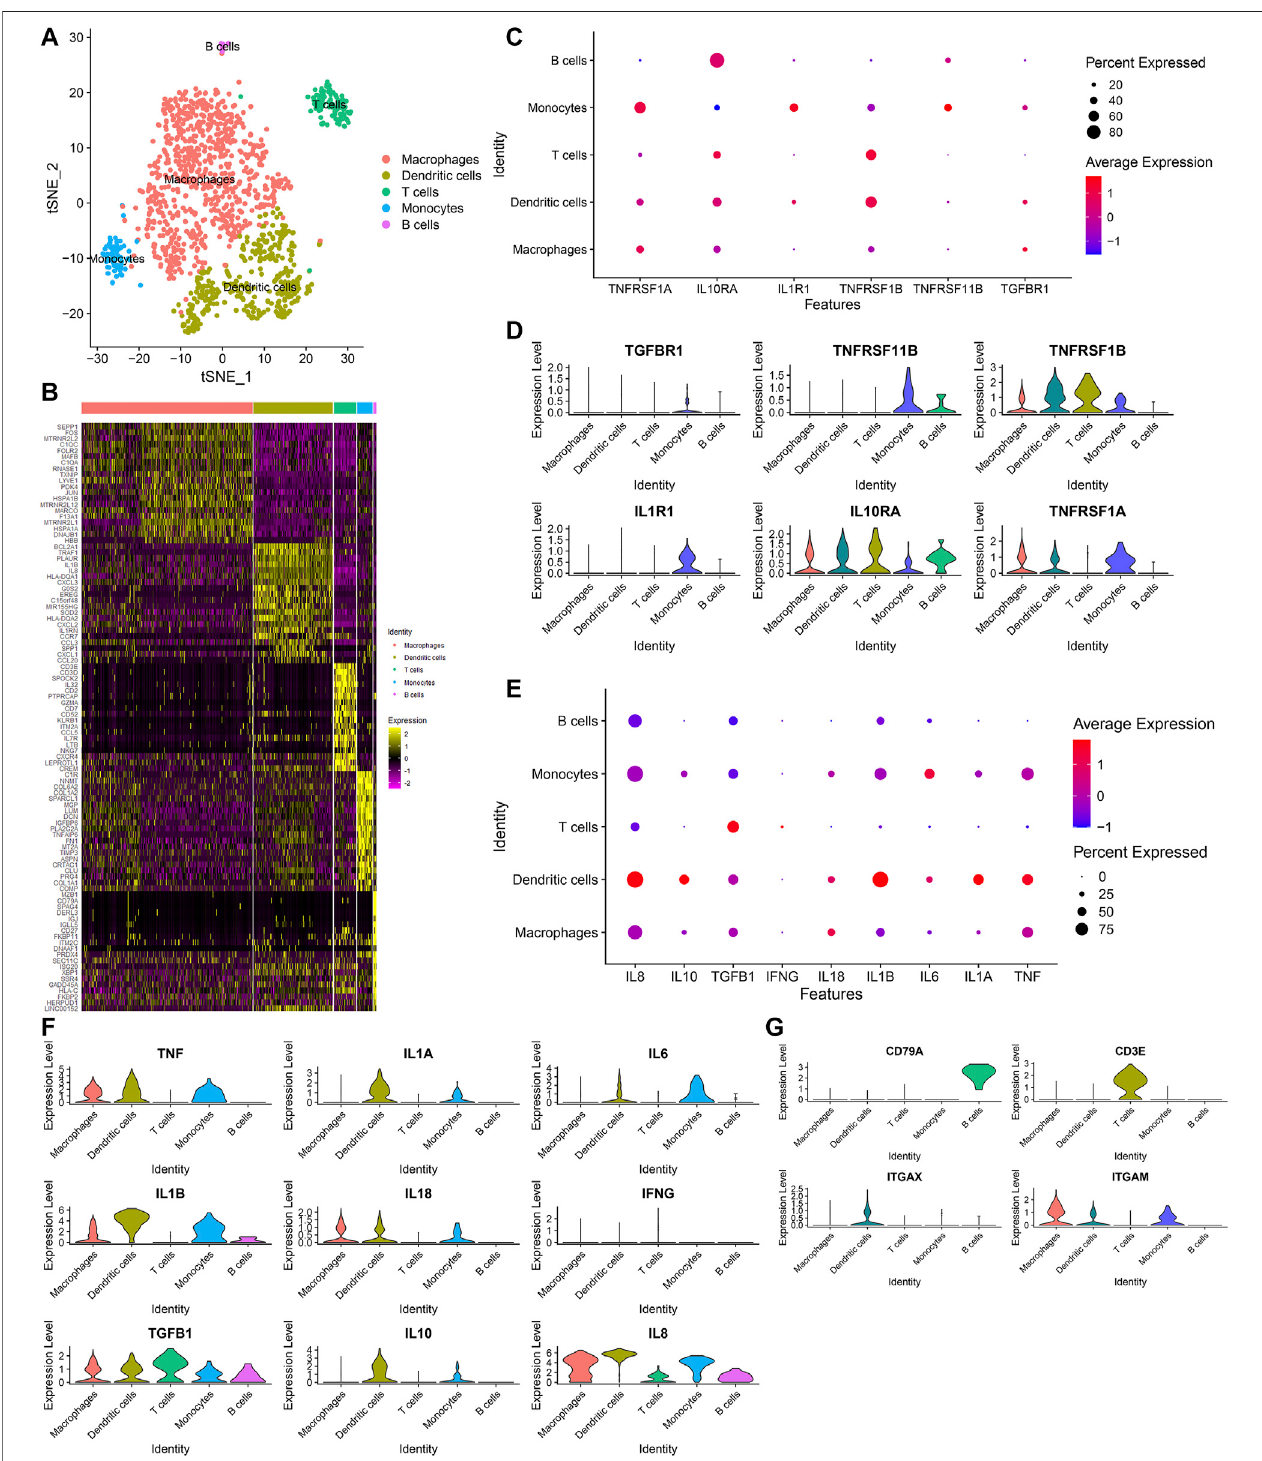
FIGURE 7 | Identi fi cation of fi ve immune cell subpopulations and associated marker genes for OA synoviocytes. (A) Visualization of fi ve cell subpopulations with unique colors. (B) Heatmap for the scaled expression of the top 20 marker genes for each cell subpopulation. (C,D) Visualization of the expression levels of cytokine receptor marker genes for each cell subpopulation. (E,F) Visualization of the expression levels of in fl ammatory cytokine marker genes for each subpopulation. (G) Visualization of the expression levels of surface markers for each subpopulation.